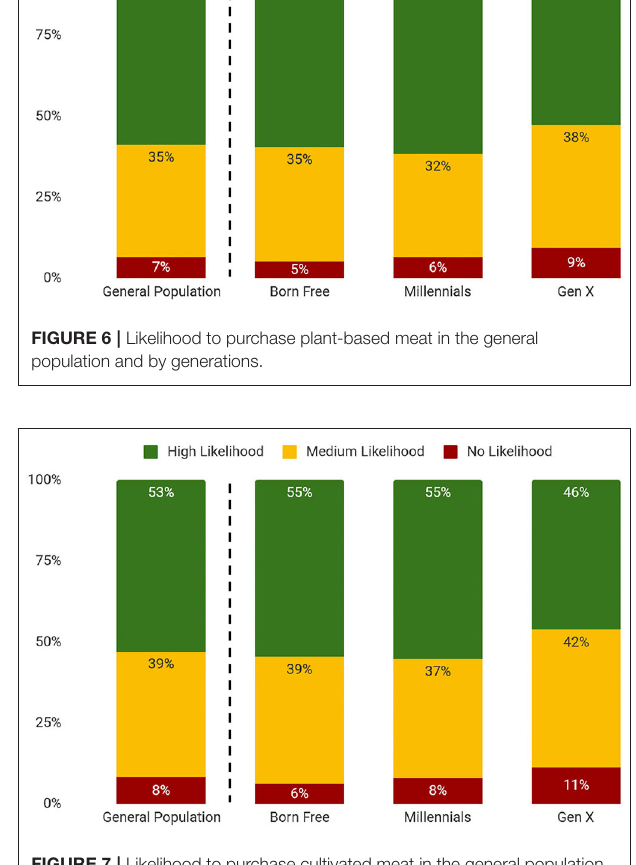
FIGURE 7 | Likelihood to purchase cultivated meat in the general population and by